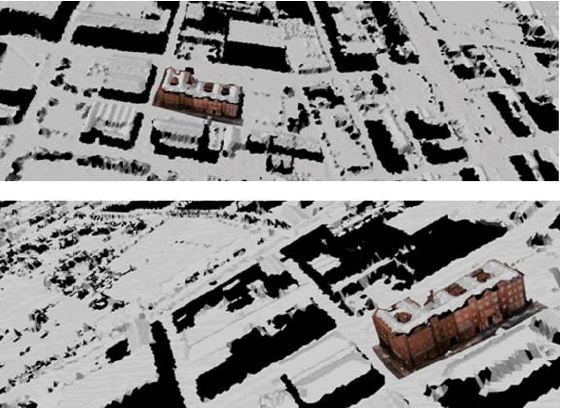
Figure 6. Integrated airborne and terrestrial datasets in the same environment (Source: Arayici,